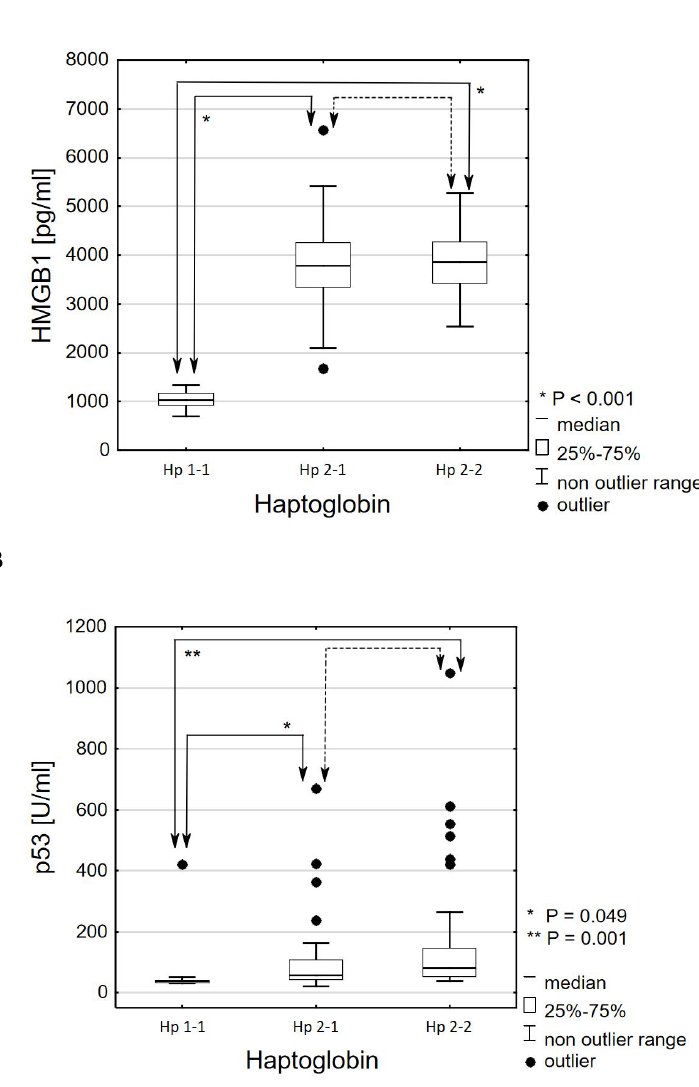
Figure 2. Effect of haptoglobin phenotype on serum high mobility group box protein 1 (HMGB1) ( A ) and p53 ( B ) extracellular secretion in patients with type 2 diabetes. The HMGB1 extracellular secretion is expressed as pg / mL serum ± IQR. * p < 0.001—statistical significance between Hp1-1 (control group) and Hp2-1 or Hp2-2. p > 0.05—no statistically significant differences between Hp2-1 and Hp2-2. The p53 extracellular secretion is expressed as U / mL serum ± IQR. * p = 0.049, ** p = 0.001—statistical significance between Hp1-1 (control group) and Hp2-1 or Hp2-2. p > 0.05—no statistically significant differences between Hp2-1 and Hp2-2. Hp1-1—haptoglobin phenotype 1-1; Hp2-1—haptoglobin phenotype 2-1; Hp2-2—haptoglobin phenotype 2-2. All detailed results are included in the Supplementary materials (Both Table S1 and S2).